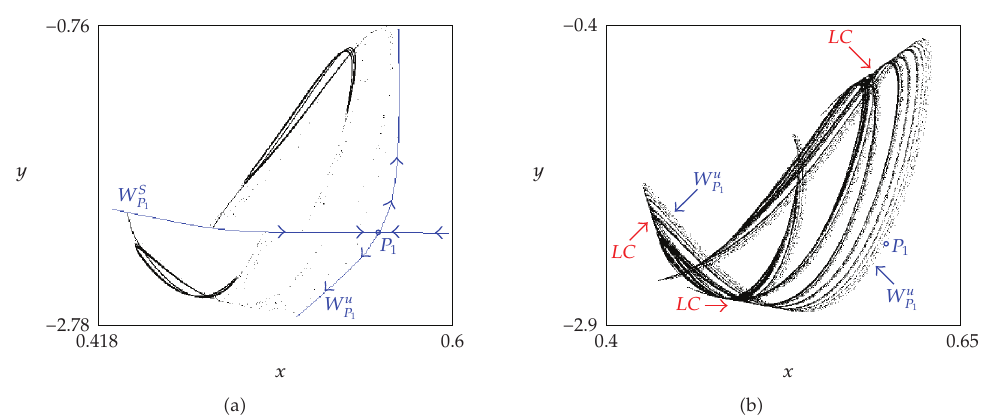
Figure 11: First homoclinic bifurcation of P 1 . (cid:5) a (cid:6) shows the contact between the two pieces of attractor A 1 (cid:8) 3 . 6. (cid:5) b (cid:6) portrays the one-piece chaotic area A and the stable set W s , at the bifurcation value e (cid:8) e 1 (cid:5) P 1 AB (cid:6) after the bifurcation, at e (cid:8) 3 . 65, whose boundary is made up of pieces of both critical lines (cid:5) denoted as (cid:6) LC (cid:6) and unstable manifold (cid:5) W u P 1